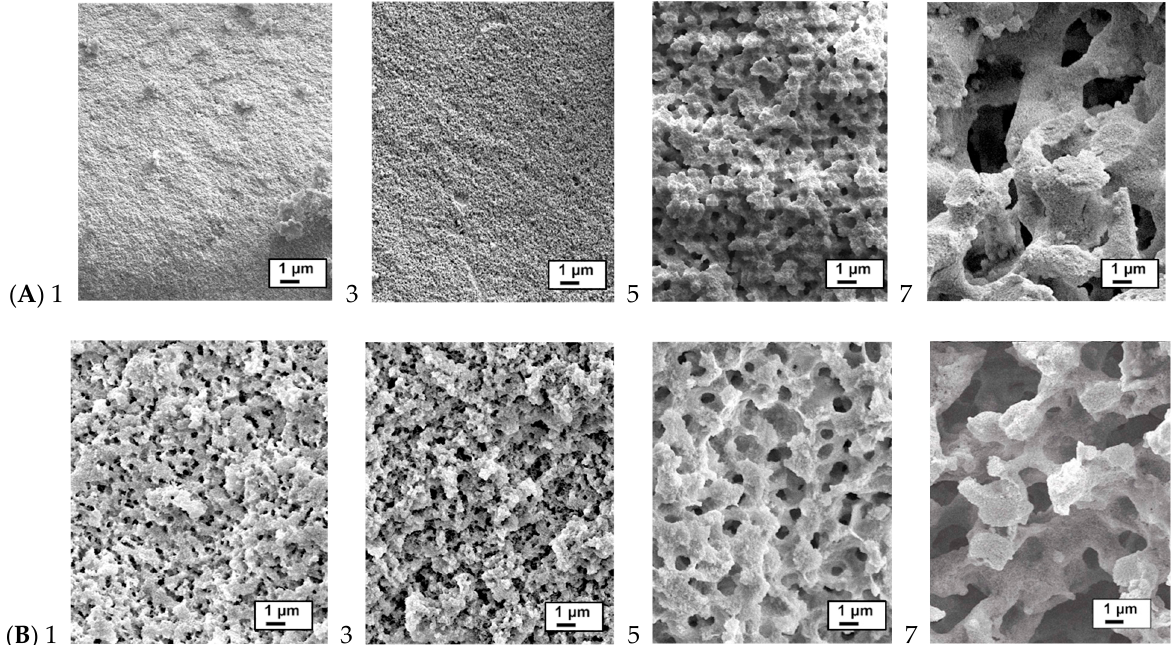
Figure 2. As synthesized silica (entries Table 1) ( A ) after calcination at 600 °C and ( B ) after 1 digestion using amylase (SEM micrographs were taken after lyophilization). The numbers shown 1–7 reflect the samples, as listed in Table 2. Table 2. Summary of surface area and total pore volume measured by N 2 absorption after 1 st enzyme digestion and after further calcination at 600 °C.